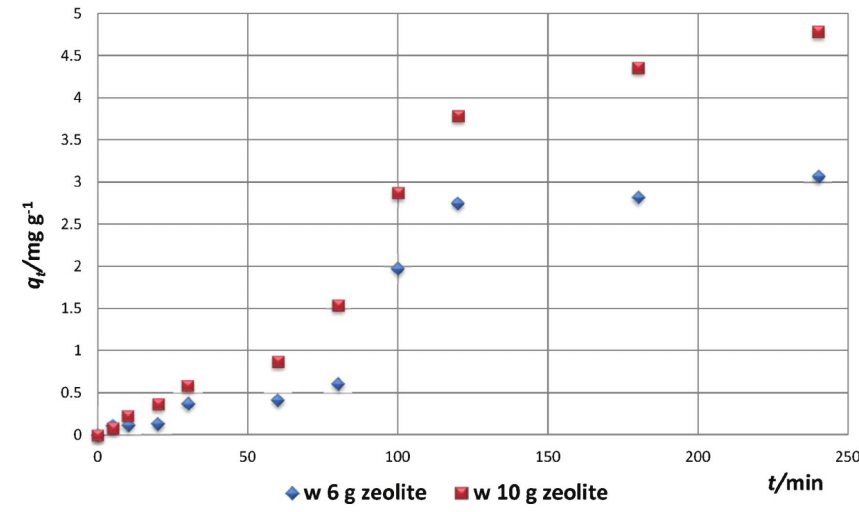
Fig. 3 – Experimental kinetics curves of vitamin E sorption on